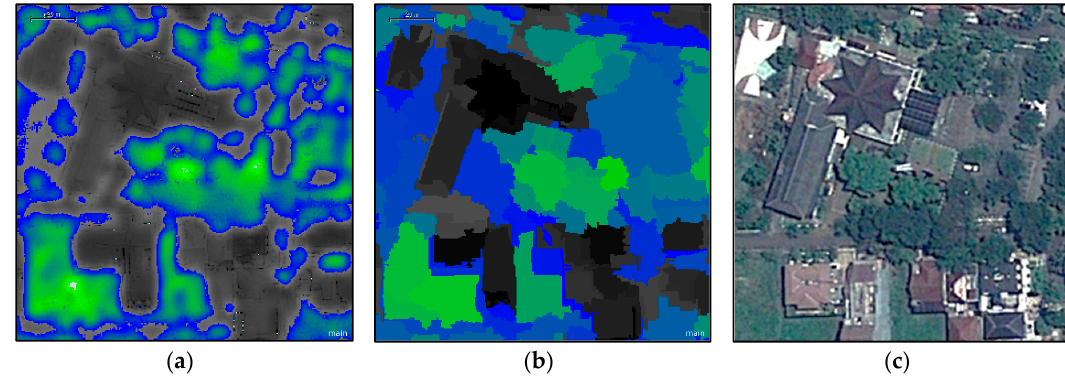
Figure 6. Impact of segmentation scale on vegetation classification. ( a ) shows segments with an Normalized Difference Vegetation Index (NDVI) of greater than zero obtained from fine segmentation and ( b ) from coarse segmentation, and ( c ) image before the segmentation process.